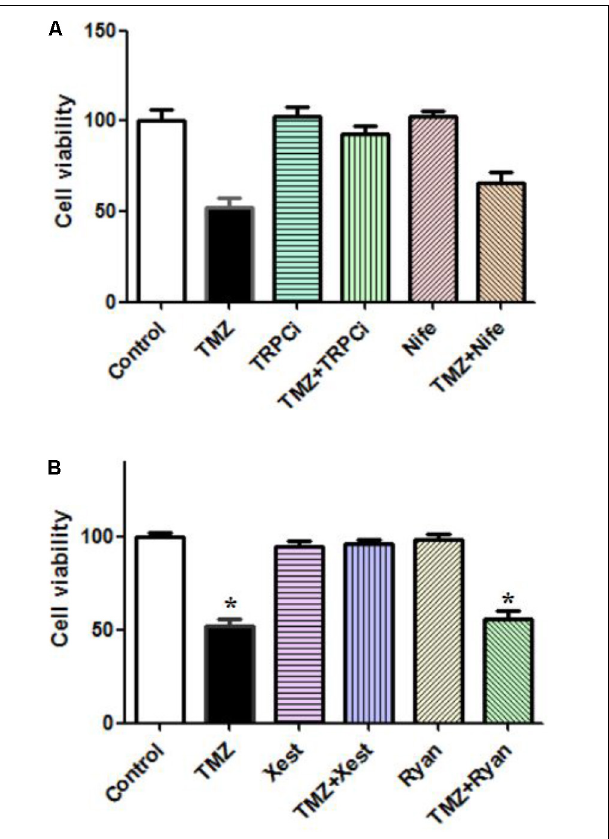
FIGURE 4 | Effect of TRPC1 or IP3R inhibitors, combined with TMZ, on the proliferation of U251 cells. (A) Cells were incubated for 20 min and MTT analysis was performed in the absence of any drug (Control) or in the presence of 5 µ M TMZ. In some experiments, 2 µ g/mL TRPC1 neutralizing antibody (TRPCi) and 1 µ M Nifedipine (Nife) were added 20 min before the addition of TMZ. (B) Cells were incubated for 20 min, and MTT analysis was performed in the absence of any drug (Control) or in the presence of 5 µ M TMZ. In some experiments, 1 µ M Xestspongin C (Xest) and 1 µ M Ryanodine (Ryan) were added 20 min prior to the addition of TMZ. Data are presented as the mean ± SEM of six replicates. ∗ Indicates a statistically significant ( P < 0.05) difference from the negative control